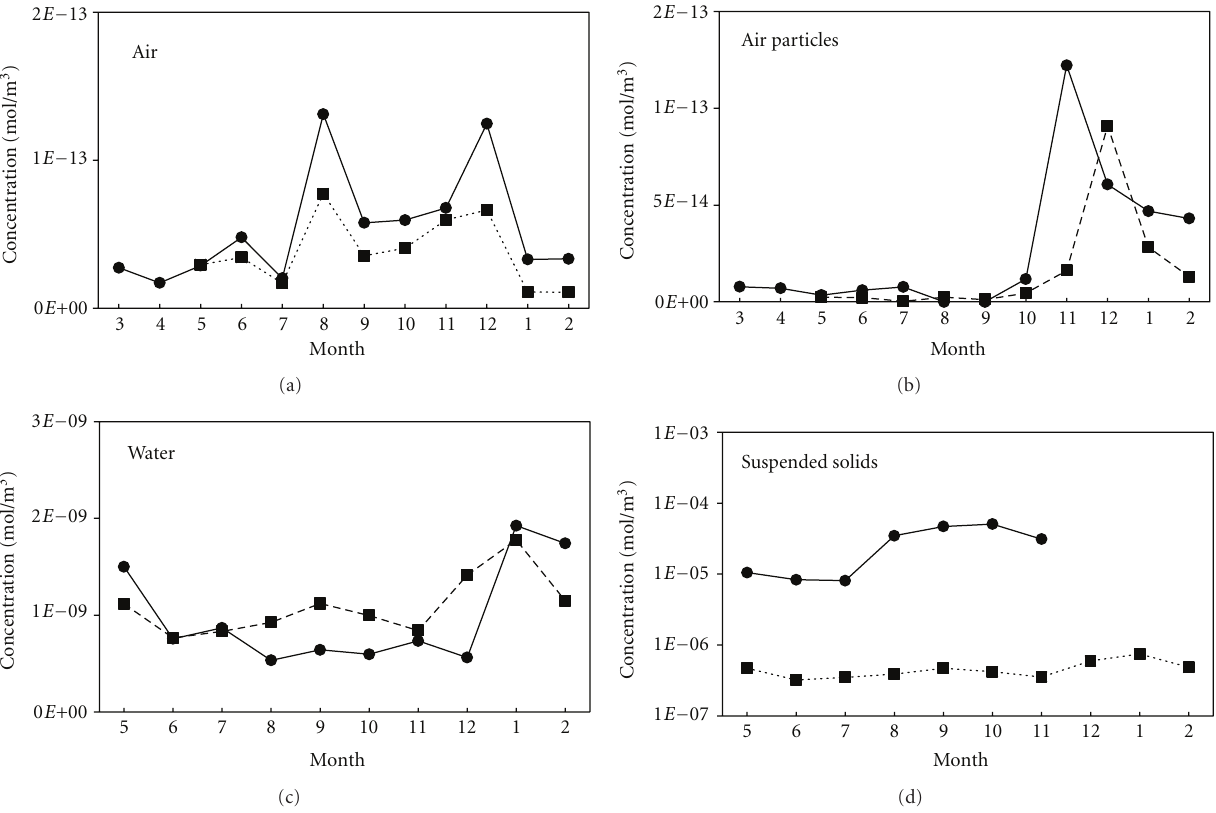
Figure 3: Seasonal variations of α -HCH concentrations in the various environmental media. Both the simulated (dashed) and measured (solid) concentrations are presented for model validation.